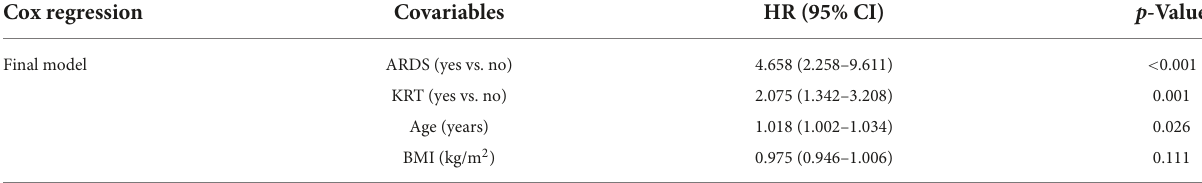
TABLE 5B Cox regression model for factors associated with 90-day mortality.